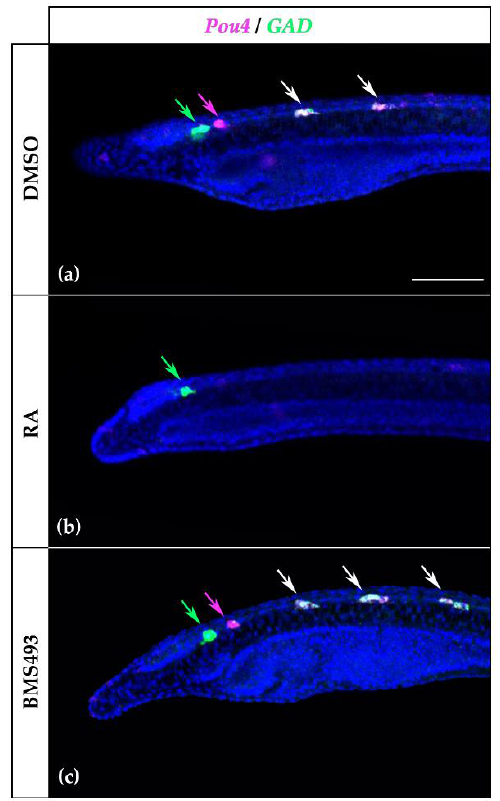
Figure 8. Co-localization analysis of Pou4 and GAD in T1-stage Branchiostoma lanceolatum embryos. ( a ) Control embryos (DMSO-treated). ( b ) Retinoic acid (RA) signaling activation with all- trans retinoic acid (RA). ( c ) RA signaling inhibition with the inverse agonist BMS493. Pou4 -expressing cells are in magenta and highlighted by magenta arrows, GAD -expressing cells are in green and highlighted by green arrows, and cells expressing both genes are in white and highlighted by white arrows. Cell nuclei are labeled with Hoechst and shown in blue. The anterior part of each embryo is presented in lateral view with the anterior to the left and the dorsal side up. For each embryo, a z-projection of the focal planes containing the nerve cord is shown. The scale bar in ( a ) is 50 μm and is valid for all panels.